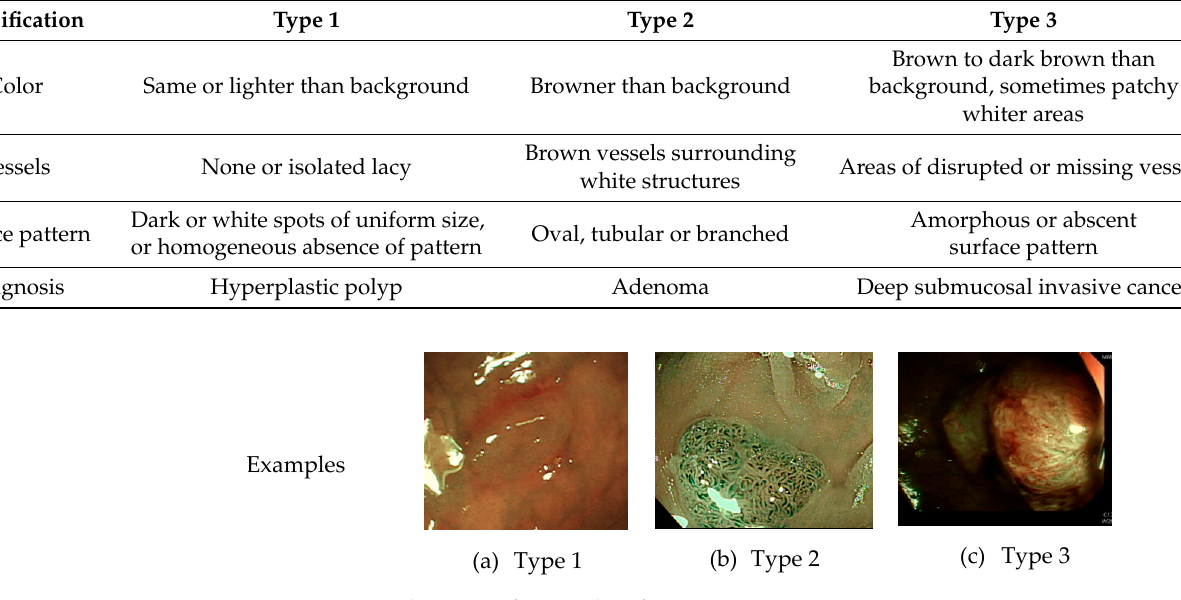
Figure 1. Example image of NICE classification.